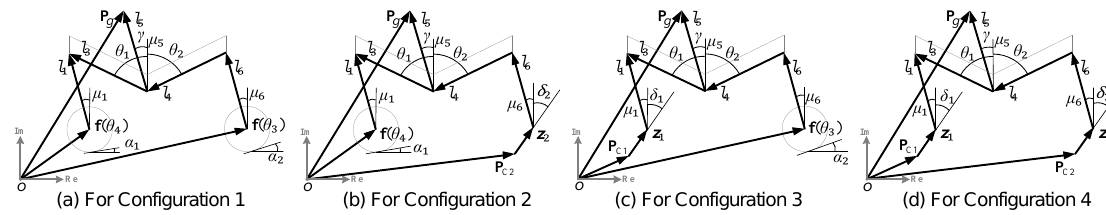
Figure 11. General kinematic scheme for the different configurations of the SCMS.